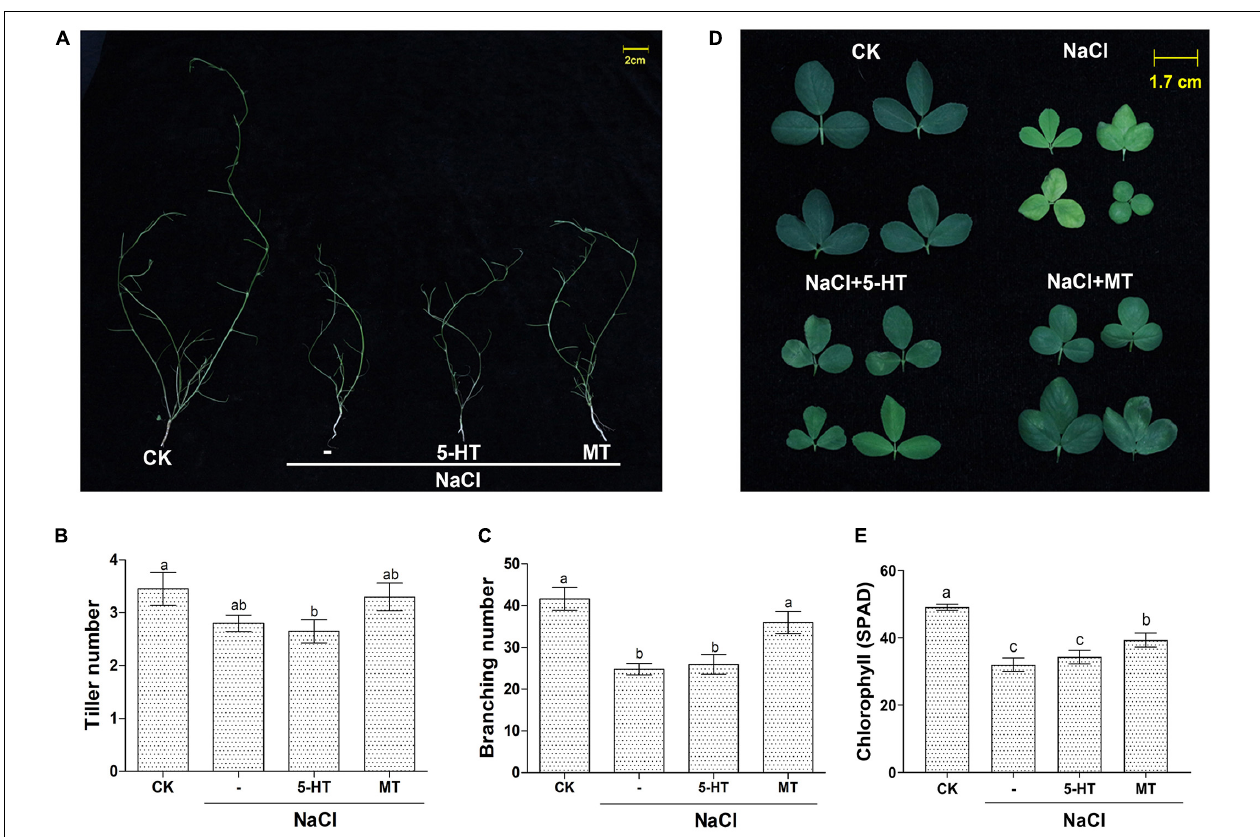
FIGURE 5 | Detailed parameters of soil-grown alfalfa seedlings upon MT and 5-HT treatment with salt stress. Seedlings of alfalfa variety, Bingchi grown in soil pot, were irrigated with 137 mM NaCl for 14 days and were then treated with 150 µ M MT or 1 µ M of 5-HT together with NaCl, respectively. On the 30th day post-treatments, growth-related parameters were measured. (A) Pictures of defoliated plants highlighting the branches; (B) Tiller number, n = 20; (C) Branching number, n = 20; (D) Representative leaf phenotype; (E) Chlorophyll content of the leaf, n = 45. Error bars show the SE between biological replicates and a t -test was performed between different treatment groups. Different numbers indicated significant differences ( p (cid:53) 0.05) between different treatments. The leaves were randomly selected from each treatment, and the relative content of chlorophyll in leaves was detected by a hand-held chlorophyll analyzer